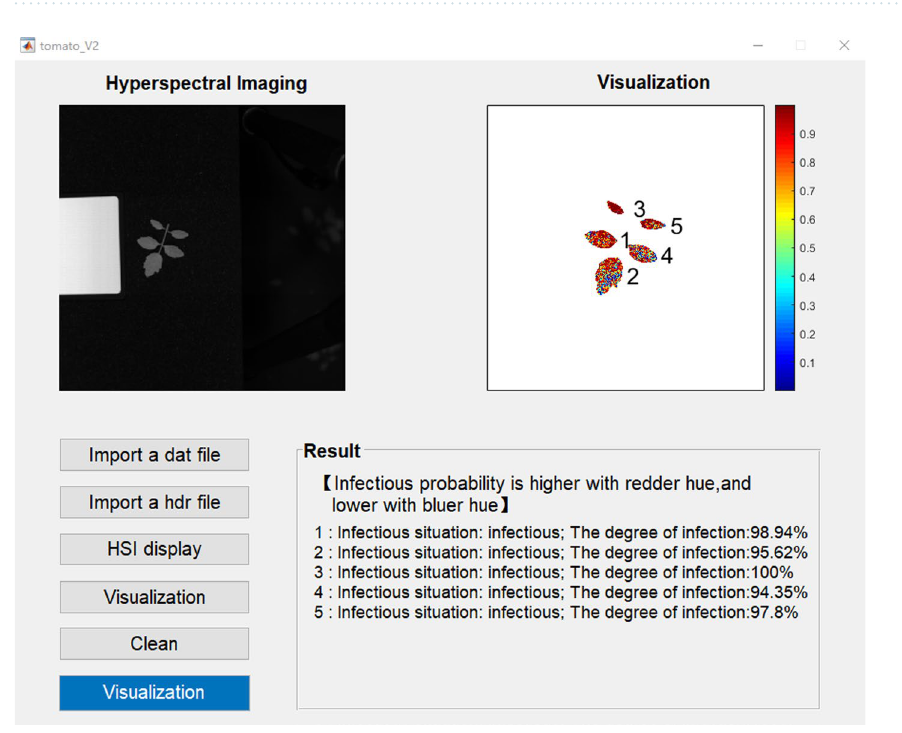
Figure 8. Visualization software